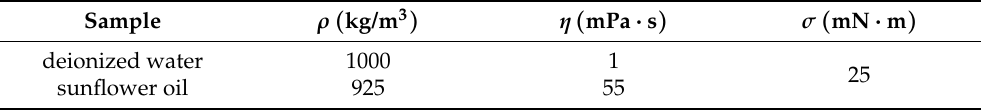
Table 1. Material properties at 25 degrees.